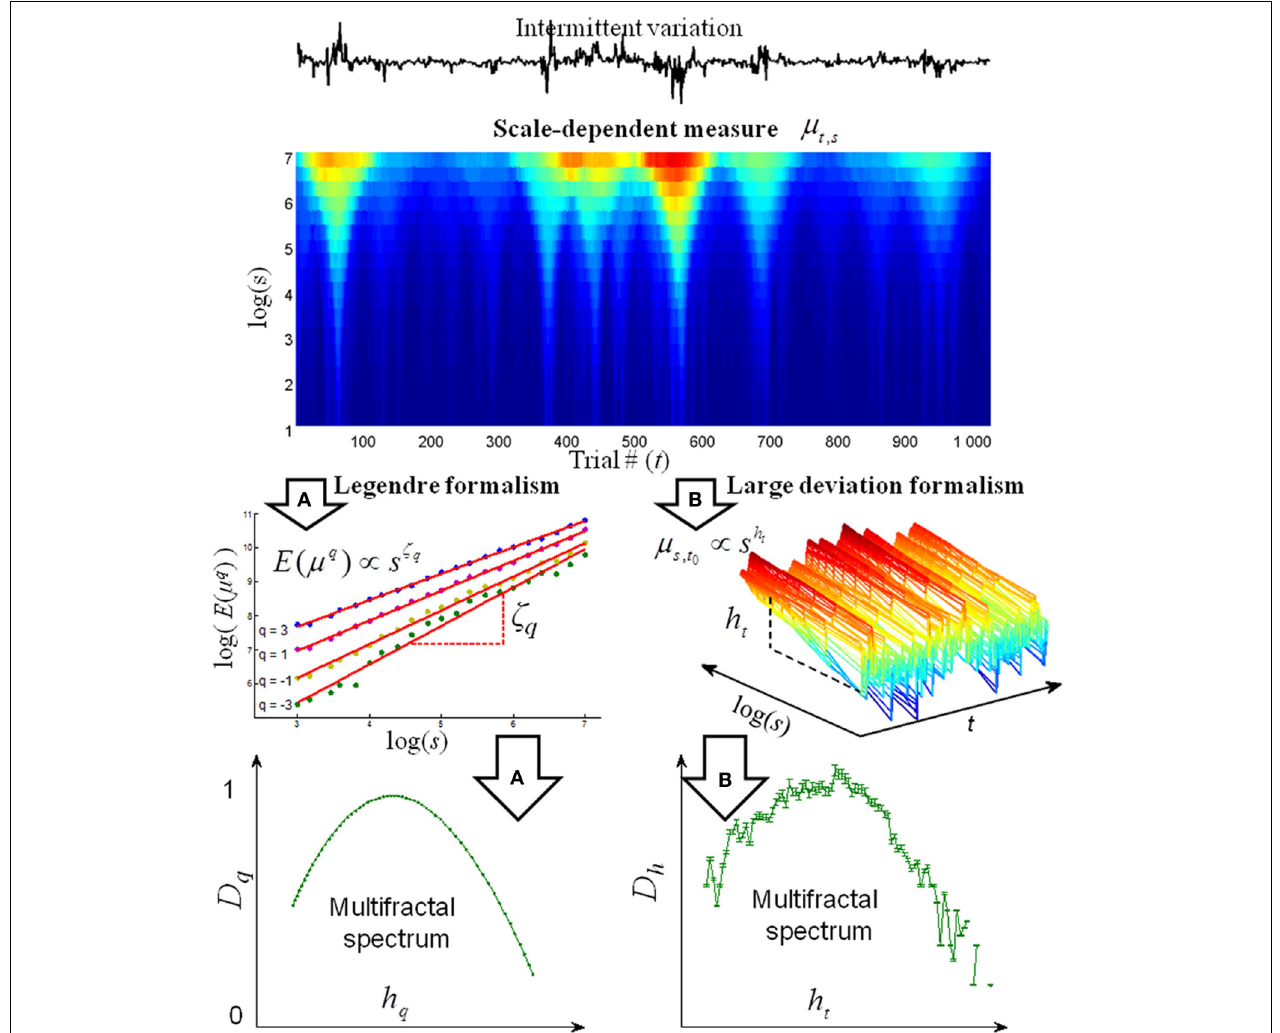
FIGURE 1 | A flow chart of the estimation of the multifractal spectrum D h by analyses within the Legendre formalism ( arrows A) and large deviation formalism ( arrows B). The basis for all multifractal analyses within both formalisms is the scale-dependent measure ( upper contour plot ) that decomposes the intermittent variation of response time series into both the time and scale domain. The red contours indicate large scale-dependent measures of the response time series that coincide with the time periods of intermittent large variations. In contrast, the blue contours indicate small scale-dependent measures that coincide with the time periods of intermittent small variations. The panel below the top arrow A indicates that the scale-dependent measure is summarized by its